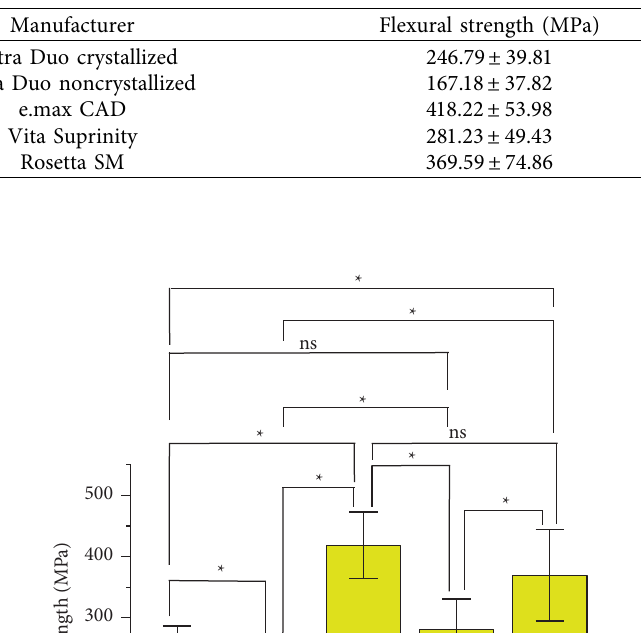
Table 3: Flexural strength values and Weibull modulus for glass-ceramics.